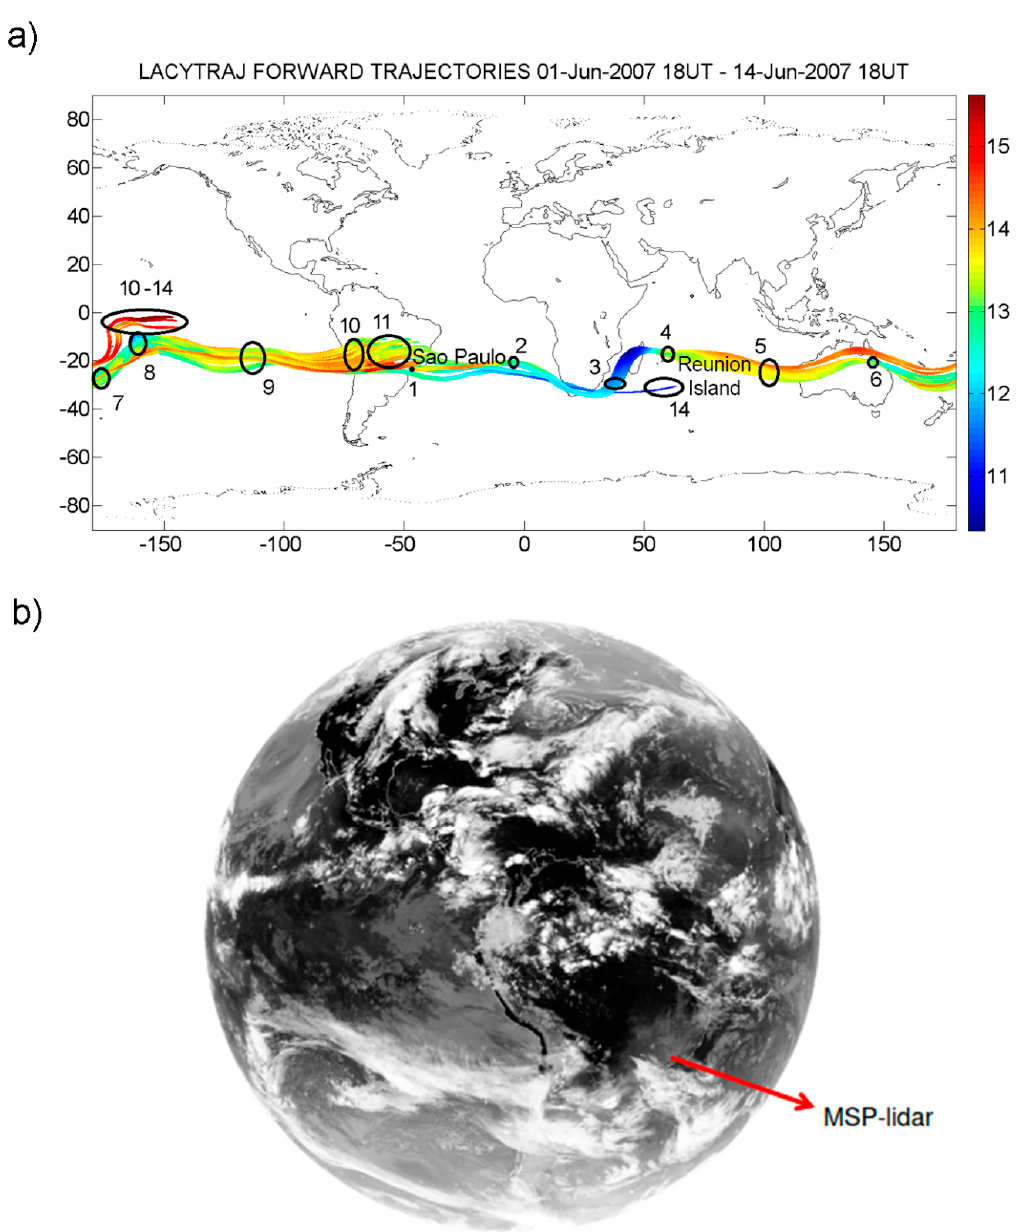
Figure 4. ( a ) Forward trajectories corresponding to the cirrus cloud detected by MSP-lidar on 1 June 2007 at São Paulo. Colors indicate the air mass altitudes (in km), and the numbers indicate the day of June 2007, corresponding to the location of the air masses. ( b ) METEOSAT InfraRed (IR) at 18 UTC on 12 June 2007, showing cirrus clouds transported by the jet stream in the Pacific before reaching again São Paulo.